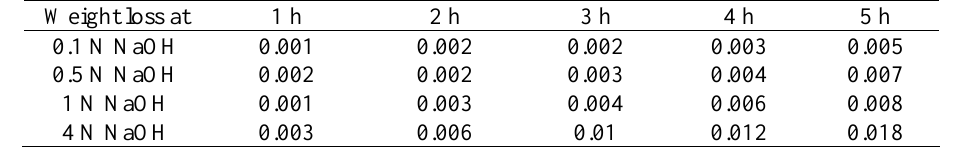
Table 5. Weight loss of Fe in